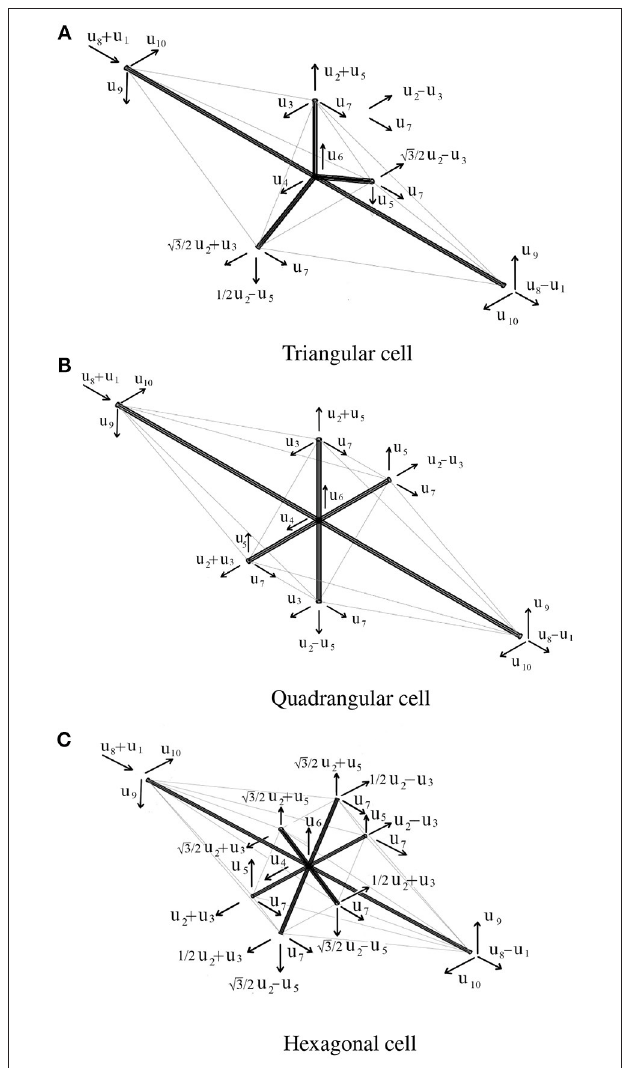
FIGURE 3 | Generalized displacements considered in the stability analysis for the three tensegrity cells. (A) Triangular cell. (B) Quadrangular cell. (C) Hexagonal